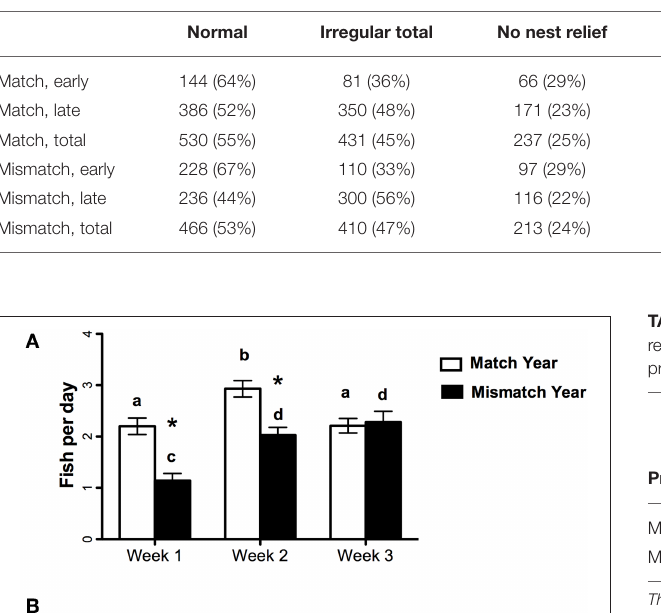
TABLE 1 | Number of nest reliefs (percentage of total) early (week 1, before capelin arrival in the mismatch year) and late in chick rearing for Normal Nest Reliefs (returner brings fish, brooding exchange), Irregular total (four other categories in columns to right), No nest relief (returner brings fish), Multiple nest relief (at same visit by returner), No fish relief (returner does not bring fish, brooding exchange), No fish, no relief (returner does not bring fish, no brooding exchange).